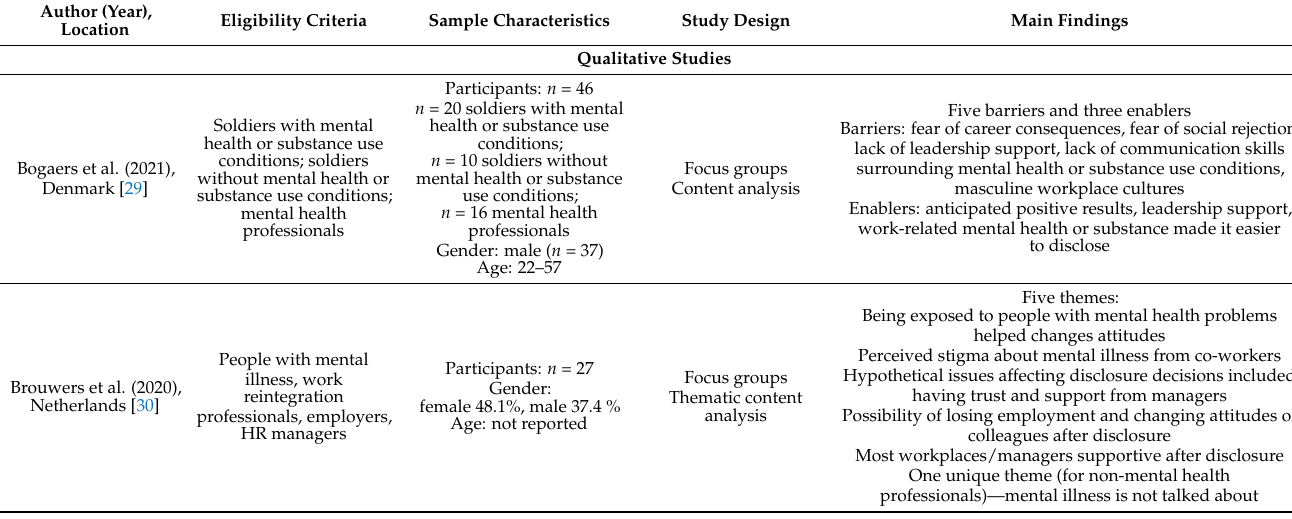
Table 1. Summary of included